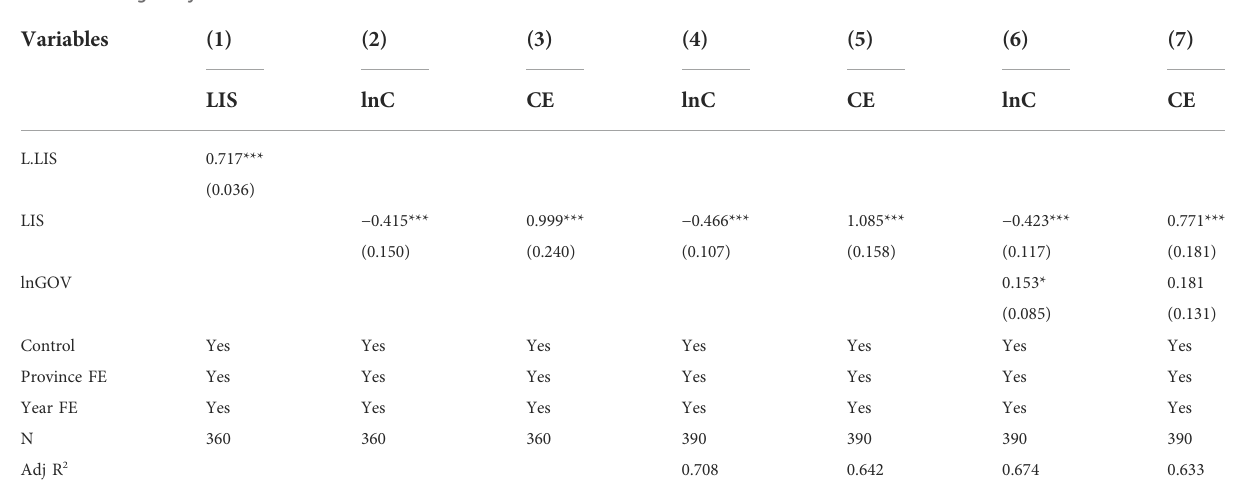
TABLE 6 Endogeneity and robustness test results.